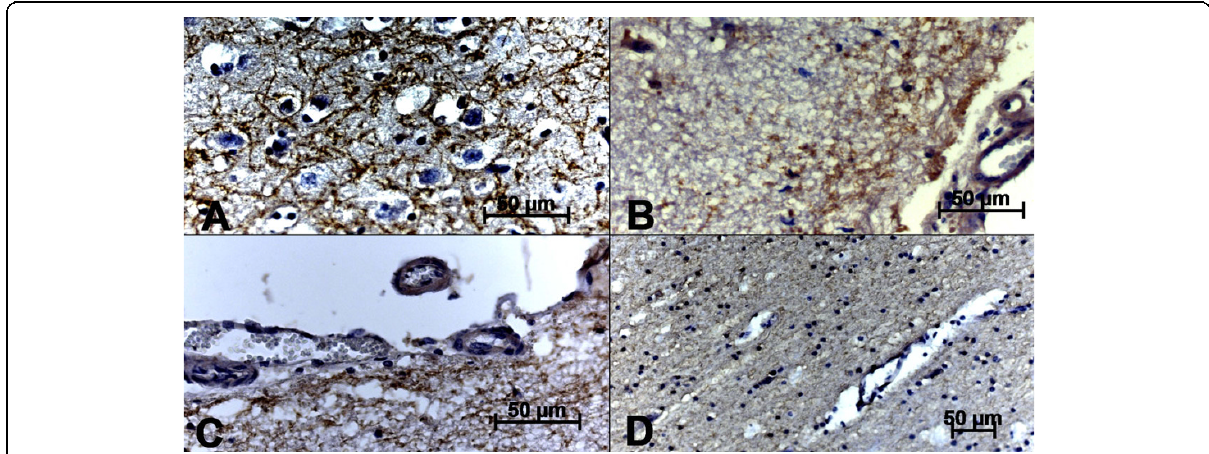
Figure 4 Photomicrography of immunohistochemical MMP-9 antigen detection in the frontal cortex of BoHV-5-infected calves (A-D) . A) area of intense immunoreactions in the parenchyma; B-C) intense positive signals in the subependimal zones; D) no positive labeling was associated to control group. The strepavidin-biotin peroxidase complex method was used (scale bar 50 μ